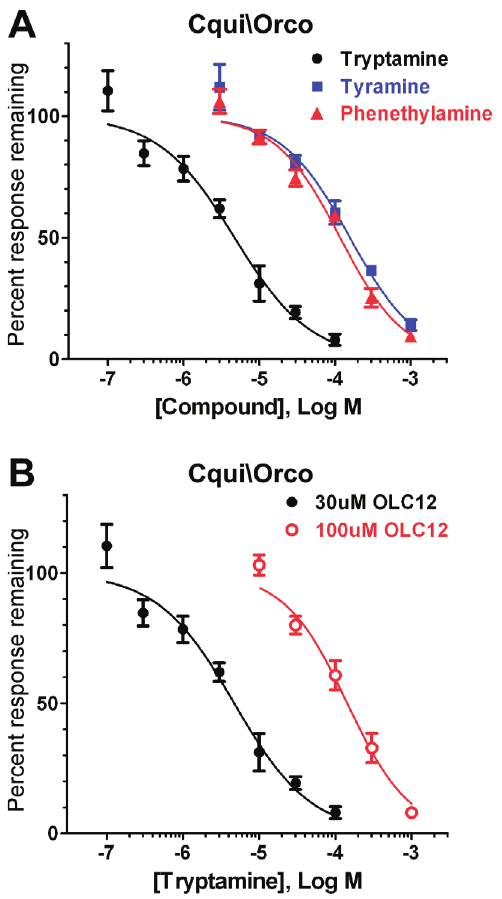
Figure 3. Trace amine antagonists of Cqui\Orco. A ) Concentration- inhibition curves for tryptamine, tyramine and phenethylamine inhibition of Cqui\Orco activated by 30µM OLC12. B ) Altering the concentration of Orco agonist (OLC12) shifts the tryptamine inhibition curve. The IC for tryptamine inhibition of Cqui\Orco 50 activation by 30µM OLC12 (4.7 ± 0.7µM, n = 5) is significantly different (p<0.0001, F-test) from the IC for tryptamine inhibition of 50 Cqui\Orco activation by 100µM OLC12 (143 ± 18µM, n =